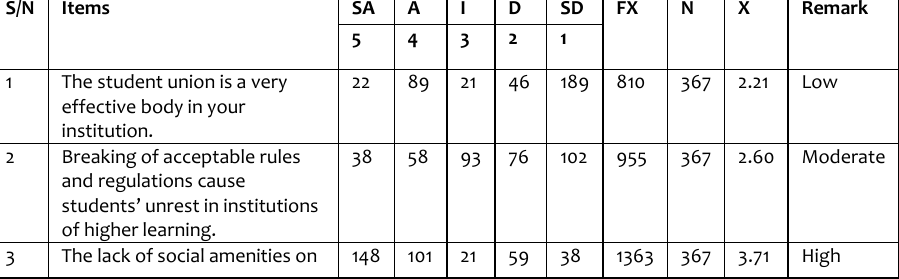
Table 6: Mean calculation of respondents based on factors that influence students’ unrest in institutions of higher learning. SA A I D SD S/N Items